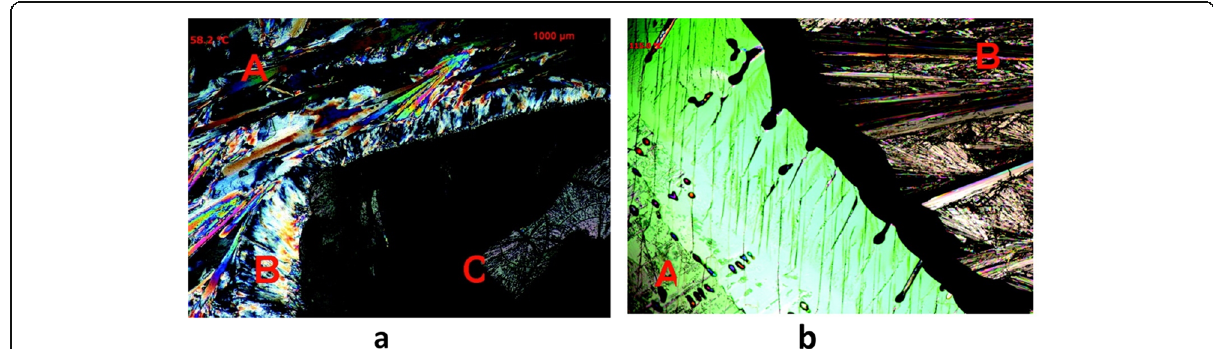
Fig. 6 Cocrystal screening of nicotinamide with Ibuprofen and Paracetamol . 6a: a- Ibuprofen, b- cocrystal phase, c- Nicotinamide; 6b: a- Paracetamol, b- Nicotinamide, no cocrystals. Reprinted from Berry et al. 2008 with permission from the publisher